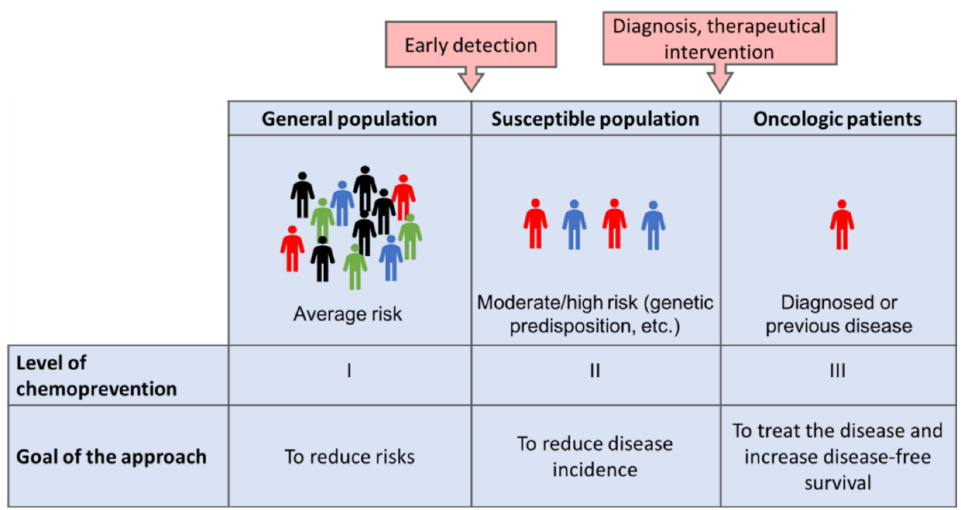
Figure 1. Levels of chemoprevention in cancer. The figure shows the three levels (I, II, III) at which a chemopreventive strategy can be implemented, and the different goals and targeted populations. (Level I of chemoprevention targets the general population, with the aim of reducing risks of de- veloping cancer. Level II of chemoprevention faces the reduction in the incidence of the disease in moderate/high-risk patients who have, for instance, a genetic predisposition to develop a certain type of cancer. Level III of chemoprevention focuses on patients who are diagnosed or have recovered from previous cancer, with the objective of treating the disease and increasing disease-free